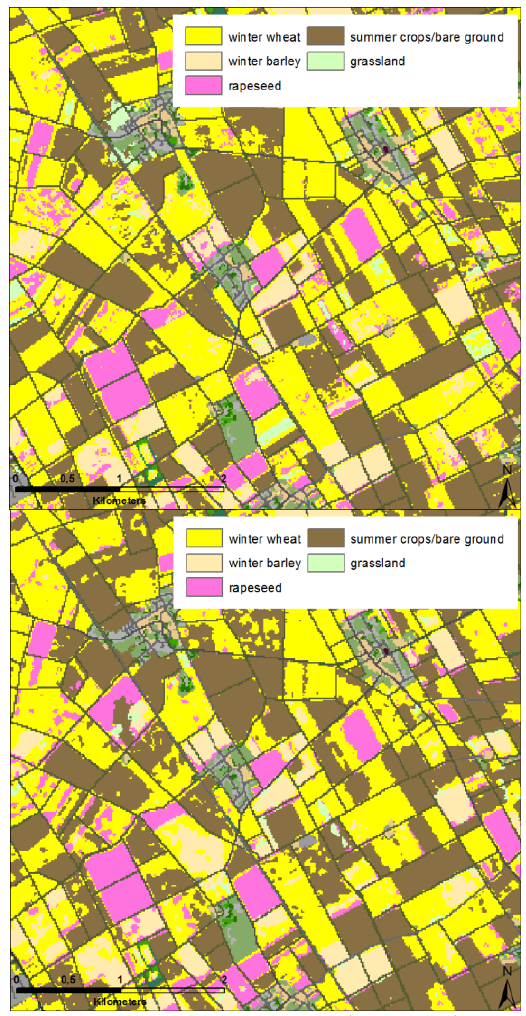
Figure 6. Subset of classification result (RE+S2+S3) for MLC (upper figure) and SVM (lower figure) Visual comparison of both classification schemes shows a coarser speckled appearance for the SVM approach (Figure 6, lower) than for the MLC approach. There is still class-wise confusion noticeable visually, especially between winter wheat and bare ground, which might result from phenological